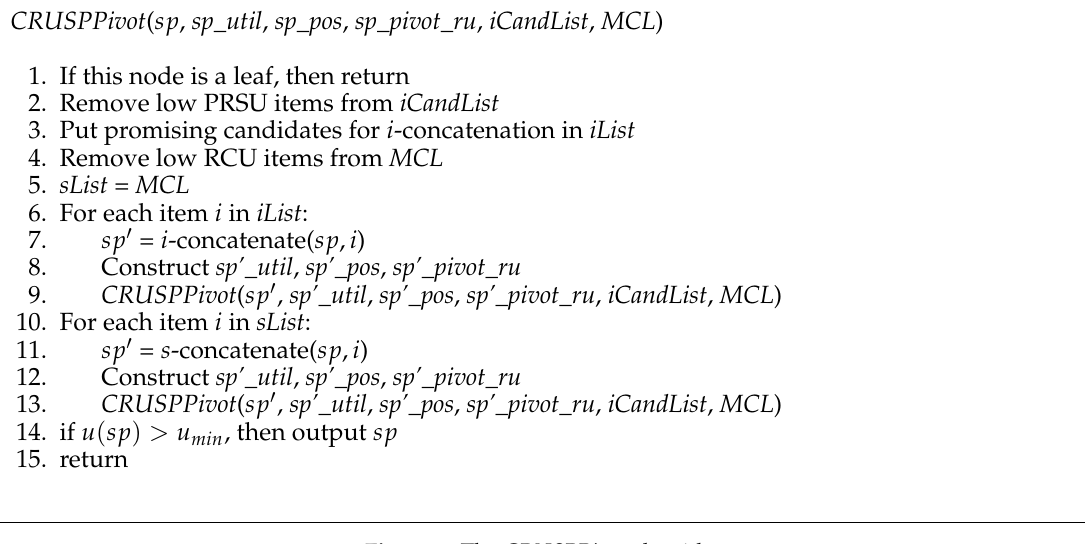
Figure 7. The CRUSPPivot